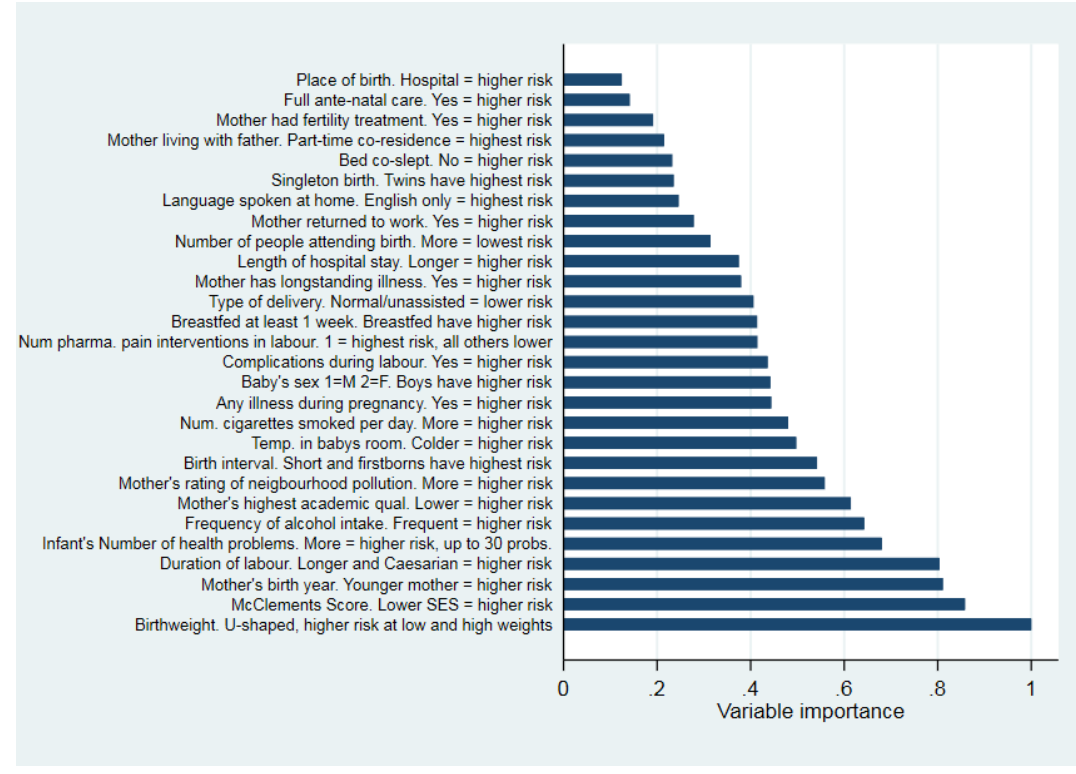
Figure 1. Variable importance plot from the RF model.